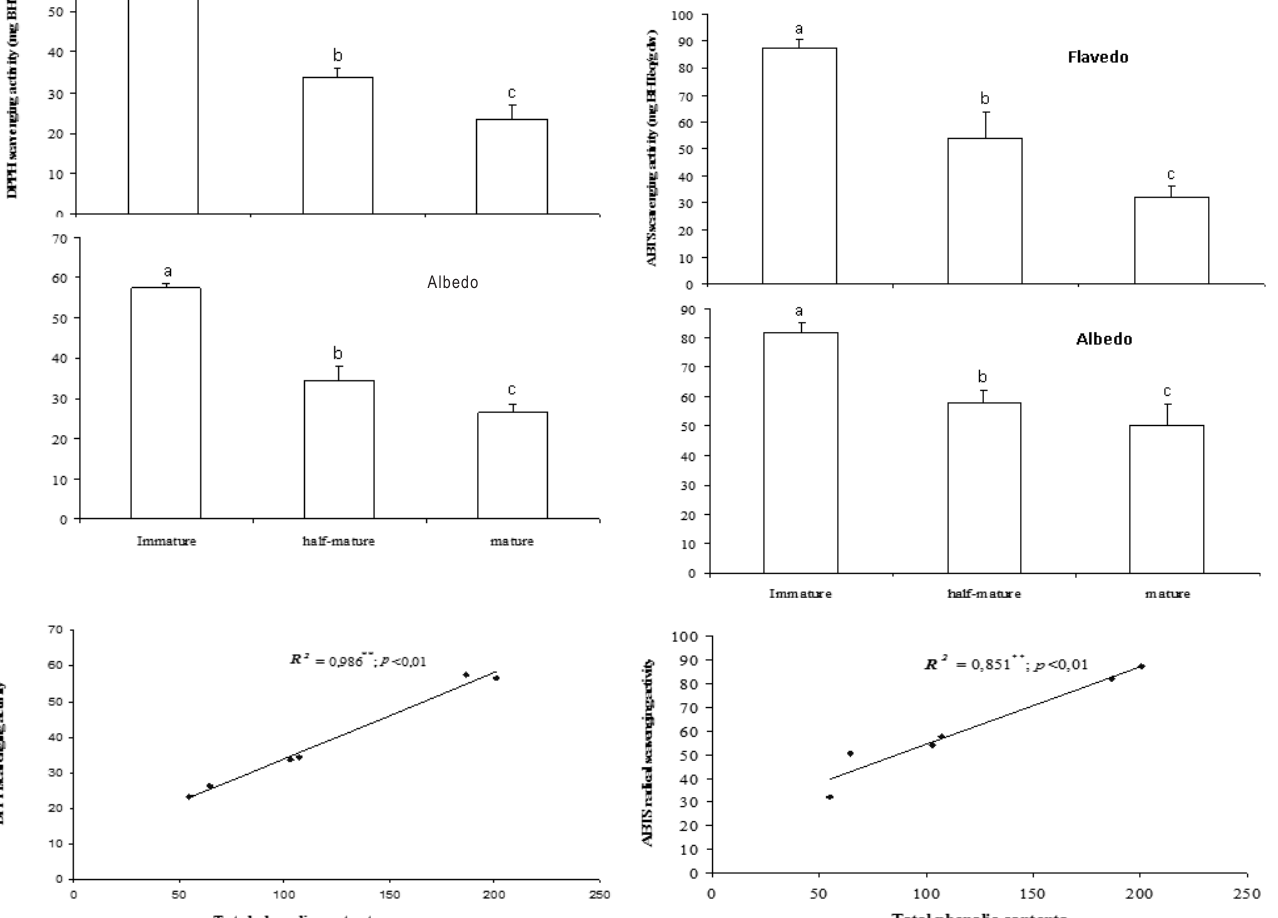
Fig. 4: ABTS radicals scavenging activity of lemon flavedo and albedo extracts (in μM TE/g extract) and its correlation with total phenolic contents. Different letter(s) on bar indicate statistically significant differences ( p <0.05); ** significance at p